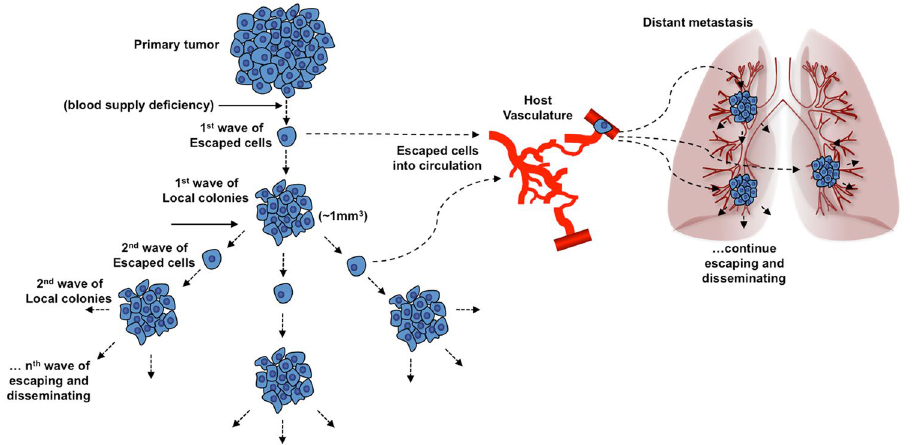
Figure 6. Schematic of the hypothetical tumor dissemination under blood-deficient conditions. Suppose that there is a hypothetical AA agent that can completely cut off the tumor blood supply. It will force the primary tumor cells to escape from the starvation area to the adjacent, well-perfused area and form new clones. When the new tumor colonies reach ~1 mm 3 , the stress of blood deficiency will force the tumor cells to escape and again form new clones. The escaped cells may also have a chance to enter the circulation and colonize in distant organs. If the stress of blood deficiency is sustained, this process would continue as a “chain reaction” that may trigger uncontrollable tumor